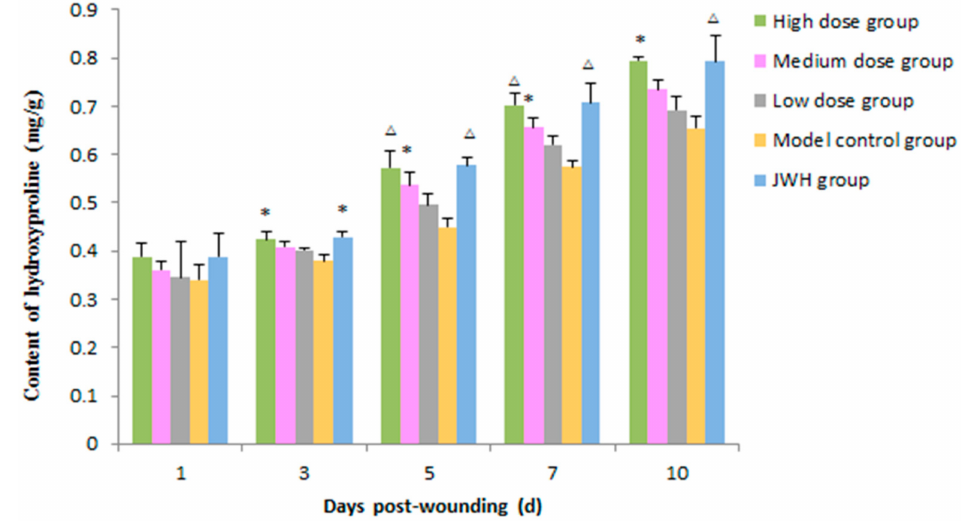
Figure 7. Effects of total flavonoids from B. balsamifera on hydroxyproline level in wound tissues of rats. Values are expressed as mean ± SD ( n = 6) as compared to the control group, * p < 0.05, ∆ p <